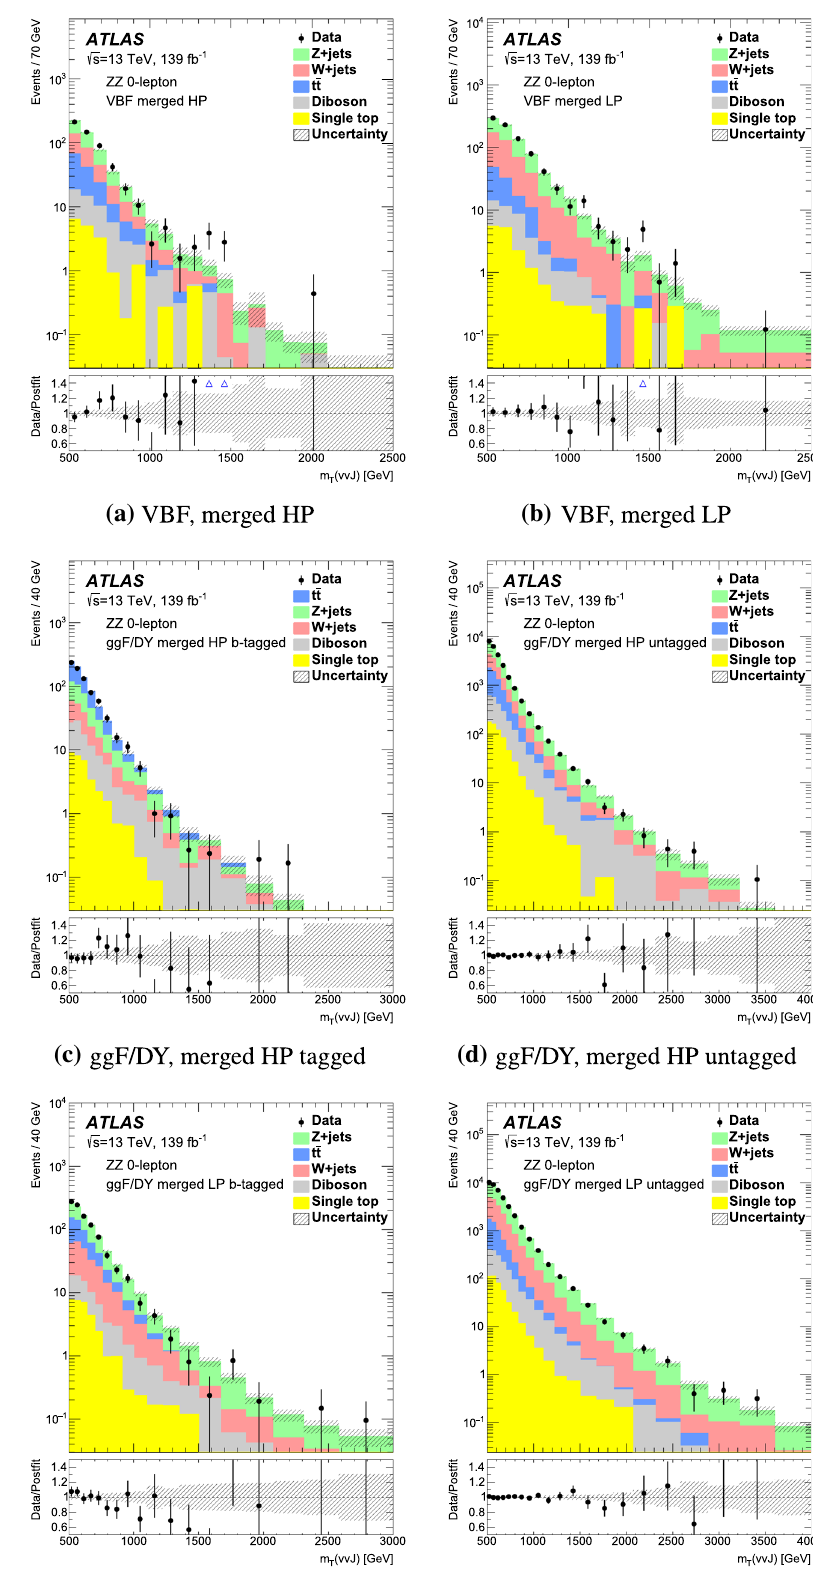
Fig. 9 Comparisons of the observed data and the expected background distributions of m T in the 6 Z Z SRs of the 0-lepton channel. The background predictions are obtained through a background-only simultaneous fit to the 6 WW and 15 Z Z SRs and their respective V + jets and t ¯ t CRs (see text). The bottom panes show the ratios of the observed data to the background predictions. The blue triangles indicate bins where the ratio is non-zero and outside the vertical range of the plot. The hatched bands represent the uncertainties in the total background predictions, combining statistical and systematic